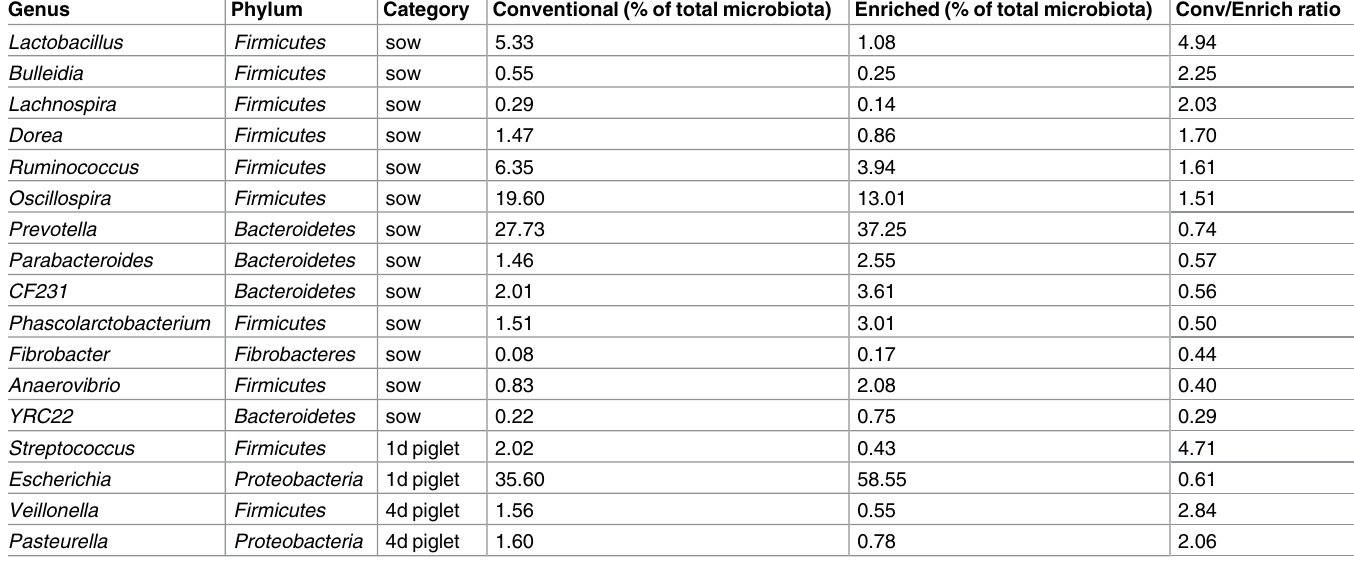
Table 2. Bacterial genera differently represented (p < 0.05)in sows kept under conventional and enriched conditions, and in their piglets. Genus